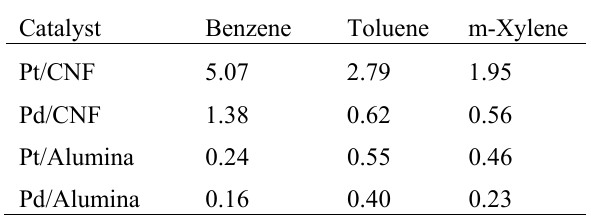
Table 7. TOF [×10 3 ] data (s -1 ) for the catalysts in the benzene combustion at 150 ºC, and for toluene and m-xylene at 160 ºC. From reference [30], with permission from